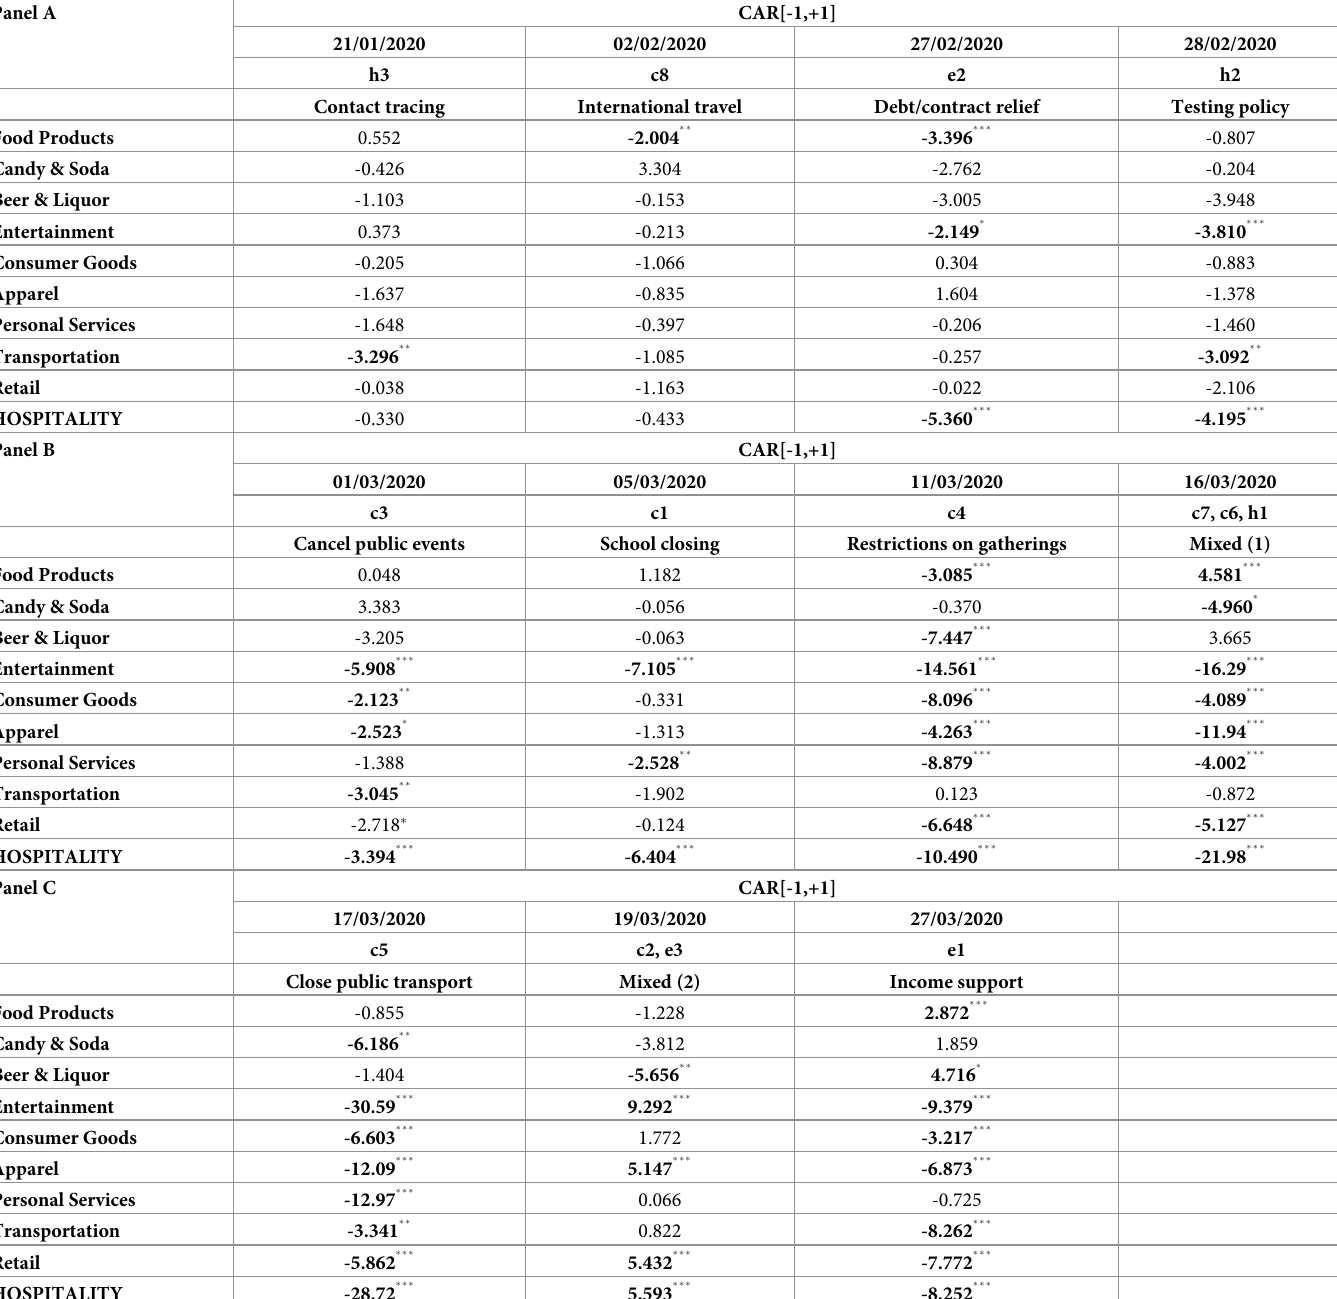
Table 3. The impact of government interventions on the hospitality industry and industries closely related to it. Panel